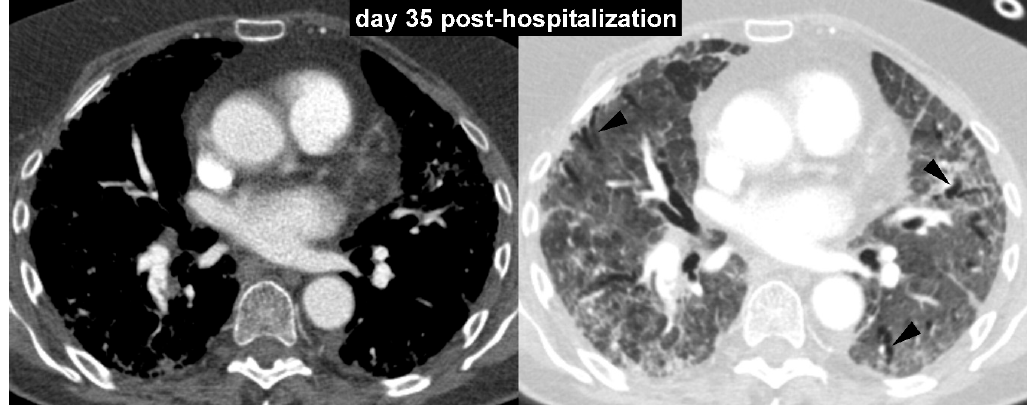
Figure 2. To monitor parenchymal lung disease, serial chest radiographs with different time intervals were obtained. However, to evaluate the response of pulmonary vascular disease to anticoagulant therapy, a further contrast-enhanced CT scan was performed after one month (day 35 post- hospitalization). The follow-up contrast-enhanced CT images with mediastinal and lung window setting (Figure 2) showed significant regression of the pulmonary embolism and lung abnormalities (both consolidations and ground-glass opacities). However, initial signs of lung architectural distortion with some traction bronchiectasis (arrowheads) were observed.